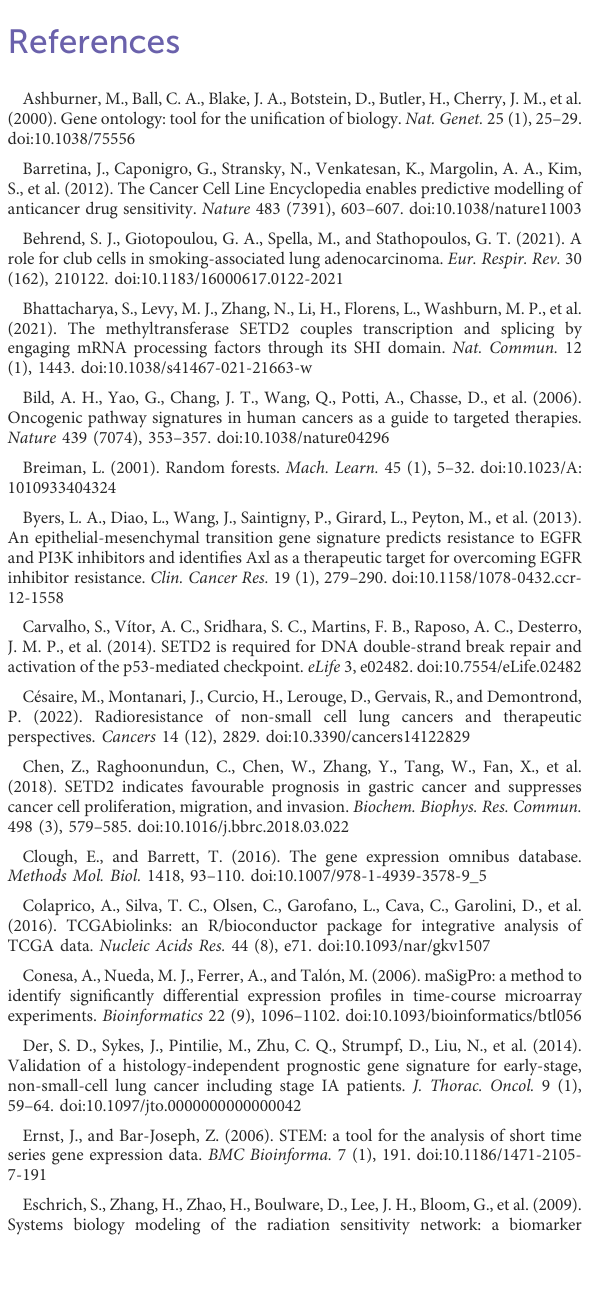
SUPPLEMENTARY FIGURE S11 SETD2 expression of NSCLC cell lines from the CCLE database. SUPPLEMENTARY FIGURE S12 Correlations between SETD2 and m6A-related genes. SUPPLEMENTARY FIGURE S13